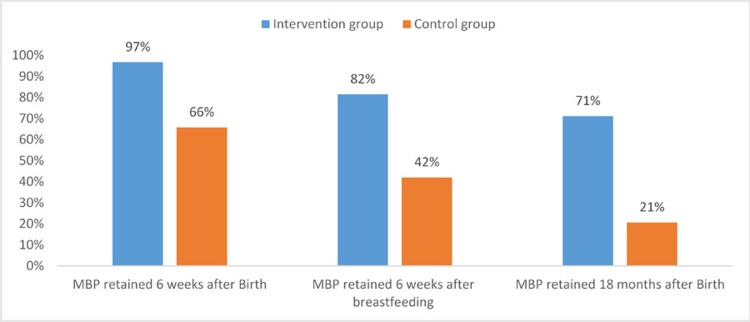
Proportion of mothers or mother-baby-pairs (MBP) remaining in case at key milestones.